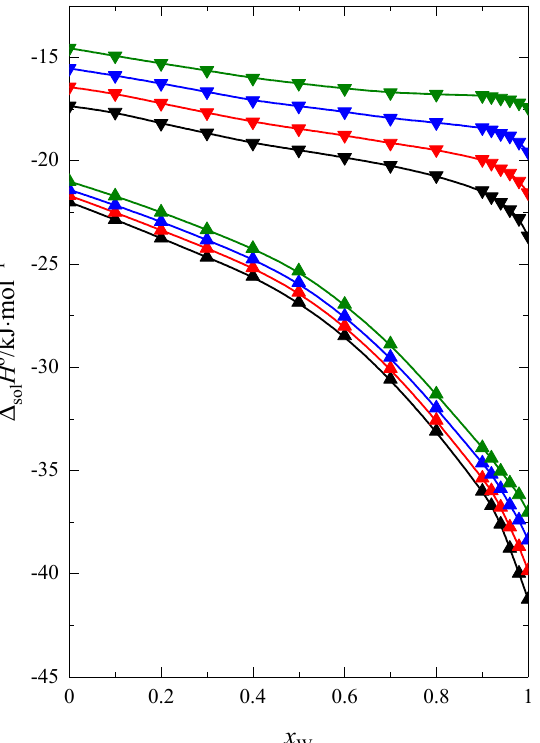
Figure 1. The standard solution enthalpy of 15C5 ( ▲ ) and 18C6 ( ▼ ) in the F + W mixtures as a function of molar fraction of water at: 293.15 K (black line), 298.15 K (red line), 303.15 K (blue line), 308.15 K (green line).